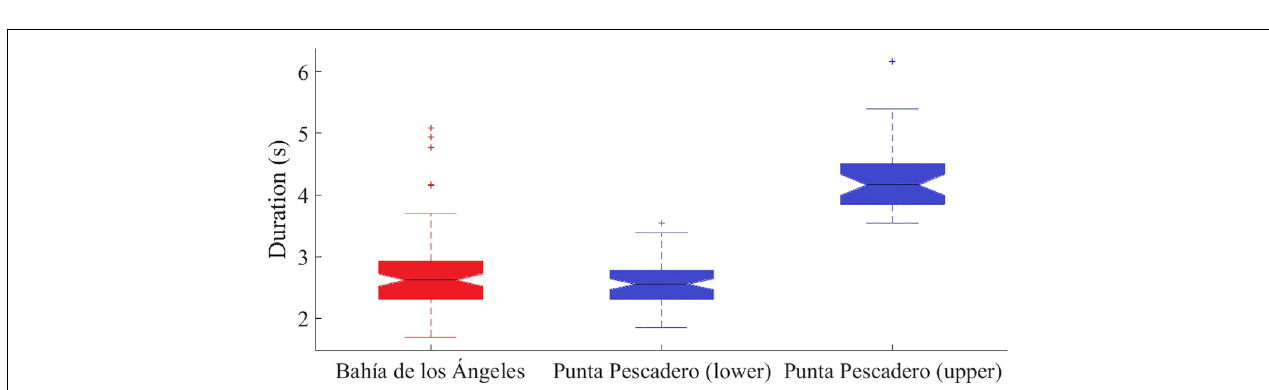
FIGURE 7 | Distribution of duration calls of Bryde’s whale. Blue bars represent calls from the south (Punta Pescadero, Baja California Sur) from August to December 2008, red bars represent calls from the north (Bahía de Los Ángeles, Baja California) from November 2006 to June 2007. The black line represents a call duration threshold level for the population divide (3.5420 s). Distribution from the north overlaps with one of the distributions found in the south.